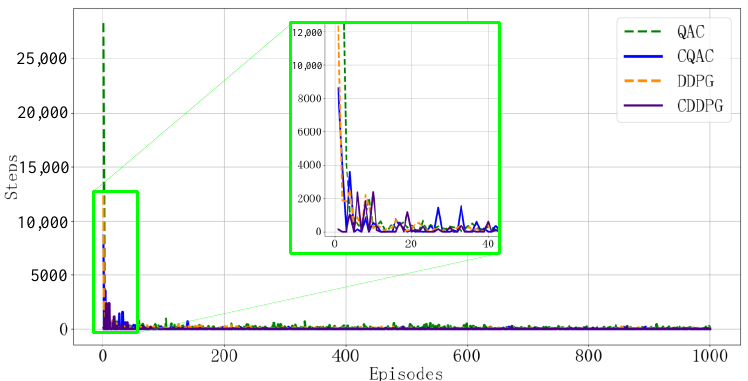
Figure 6. Training episode rewards of four algorithms.